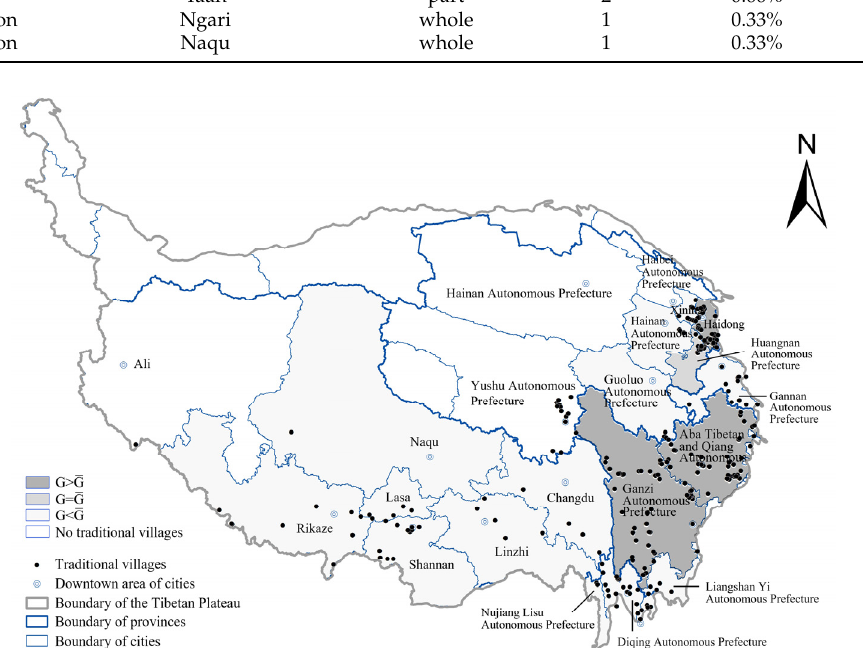
Figure 6. Distribution of villages at the city level on the Tibetan Plateau . Table 4. Statistics related to traditional villages at the city level on the Tibetan Plateau.